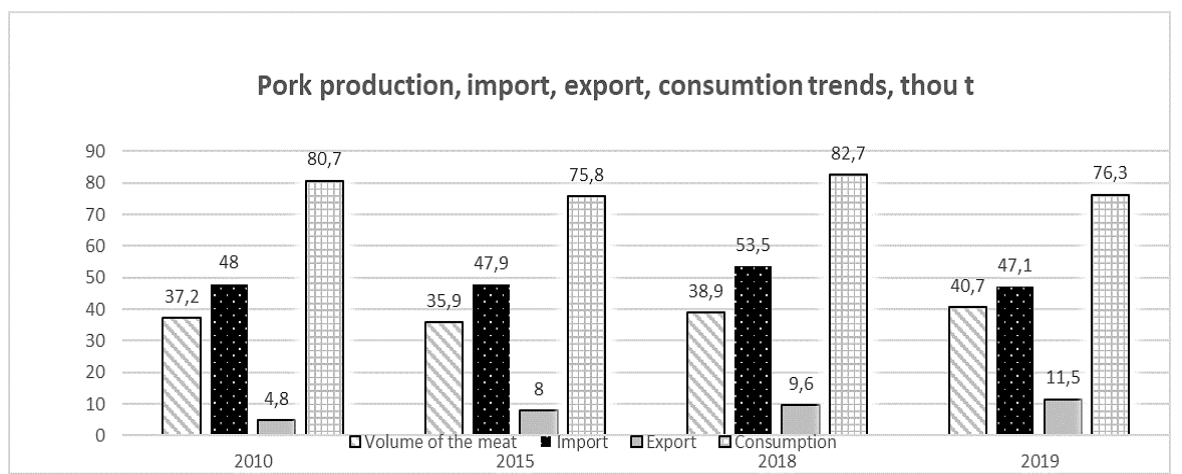
Figure 3. Pork sector in Latvia, 2010-2019 [17].